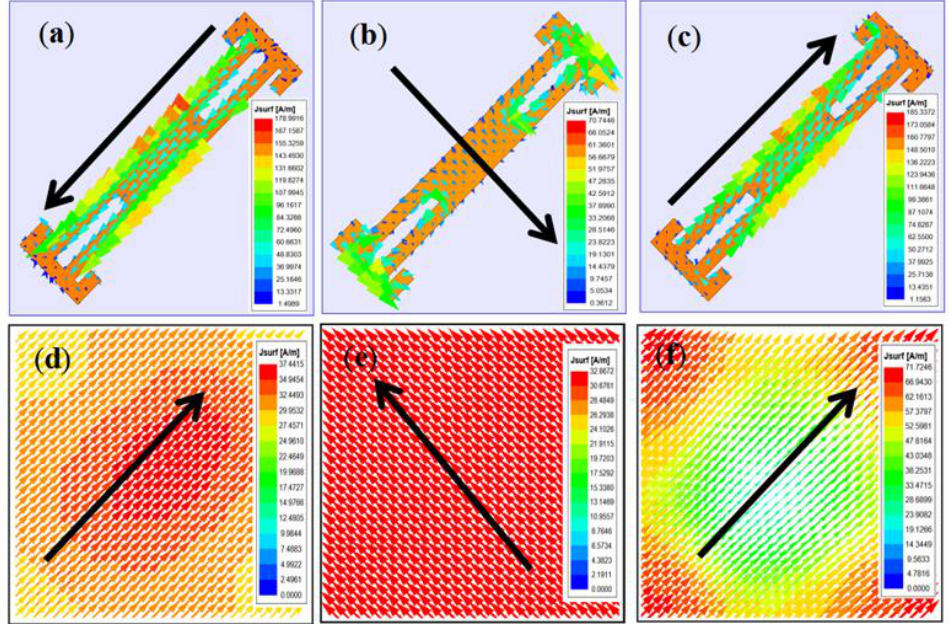
Figure 9. Surface current distributions on top layer and metallic ground plane for normal incidence in response to the v - and u -components with various resonant frequencies of ( a , b ) 10.36 GHz; ( c , d ) 22.12 GHz; ( e , f ) 29.92 GHz.